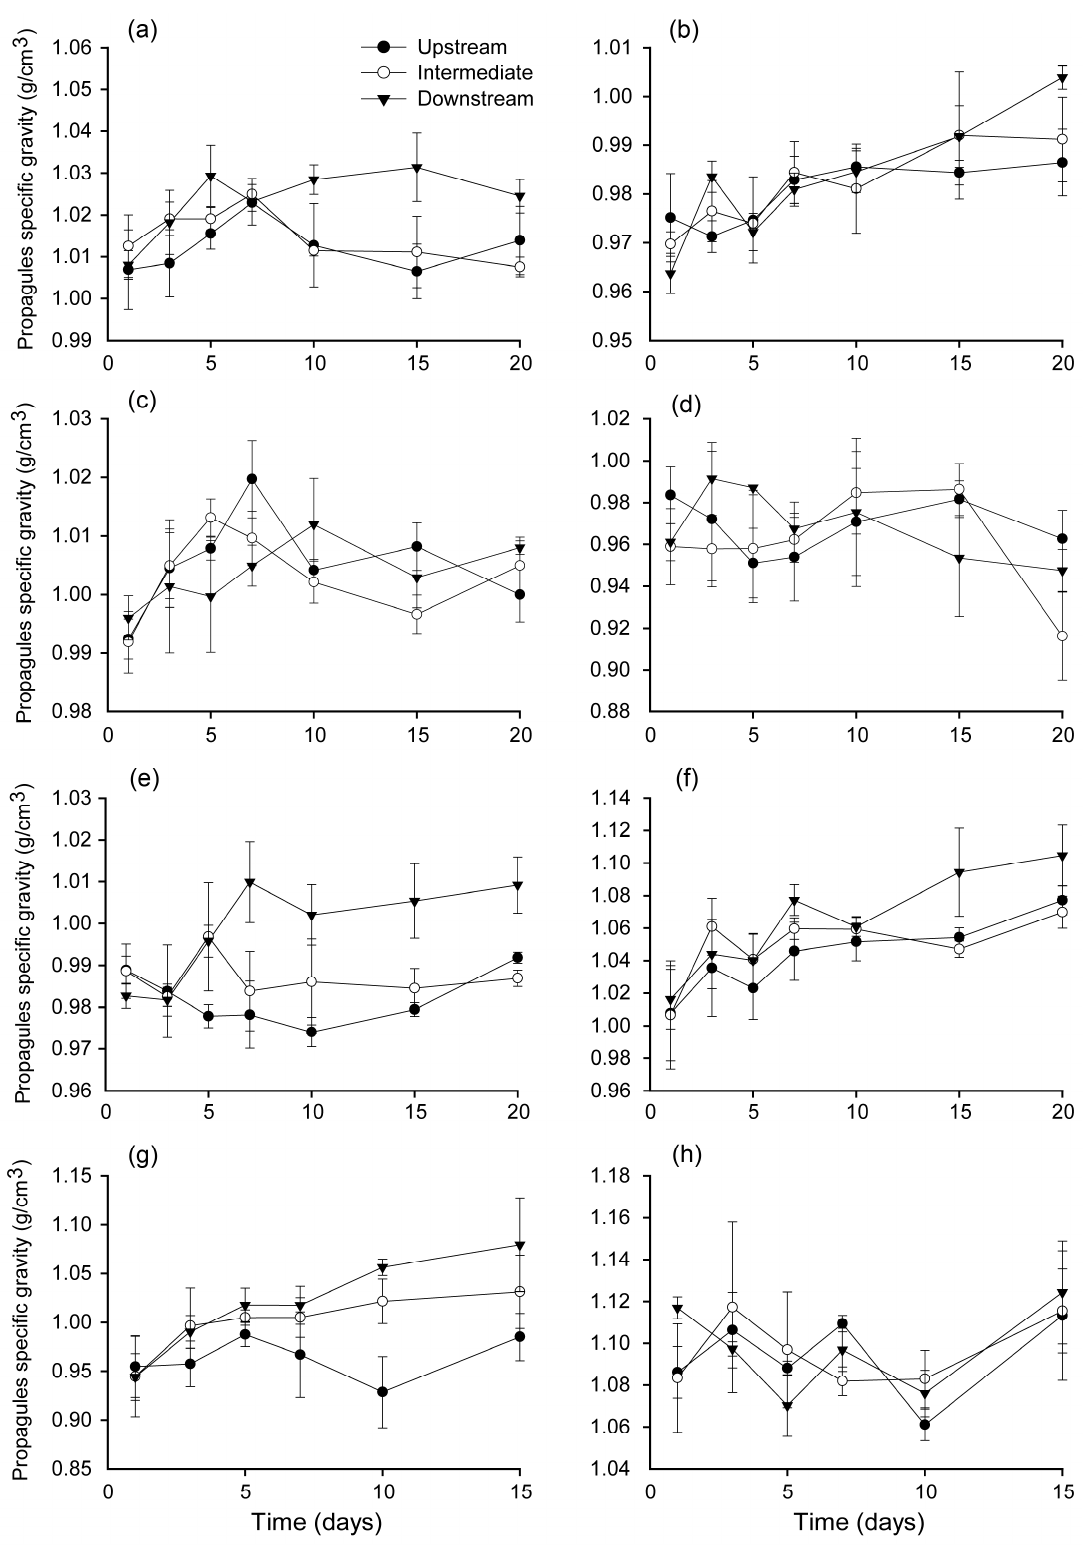
Figure 3. Changes in the specific gravity of the propagules of eight mangrove species during floating at three sites with different water salinity regimes. Mean specific gravity ( ± SE) shown from 20 propagules placed in each of three replicated grid of woody frame. ( a ) Bruguiera gymnorhiza ; ( b ) Ceriops tagal ; ( c ) Bruguiera sexangula ; ( d ) Lumnitzera racemosa ; ( e ) Rhizophora stylosa ; ( f ) Aegiceras corniculatum ; ( g ) Sonneratia caseolaris ; ( h ) Sonneratia alba